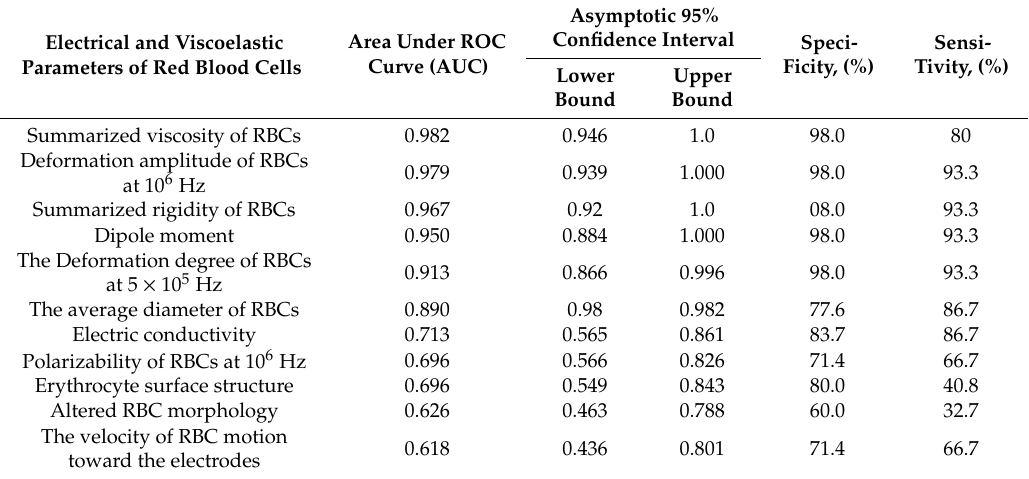
Table 3. Results of the analysis of ROC curves of erythrocyte indices in patients with diabetes by di ff erentiating the degree of rheological disorders.